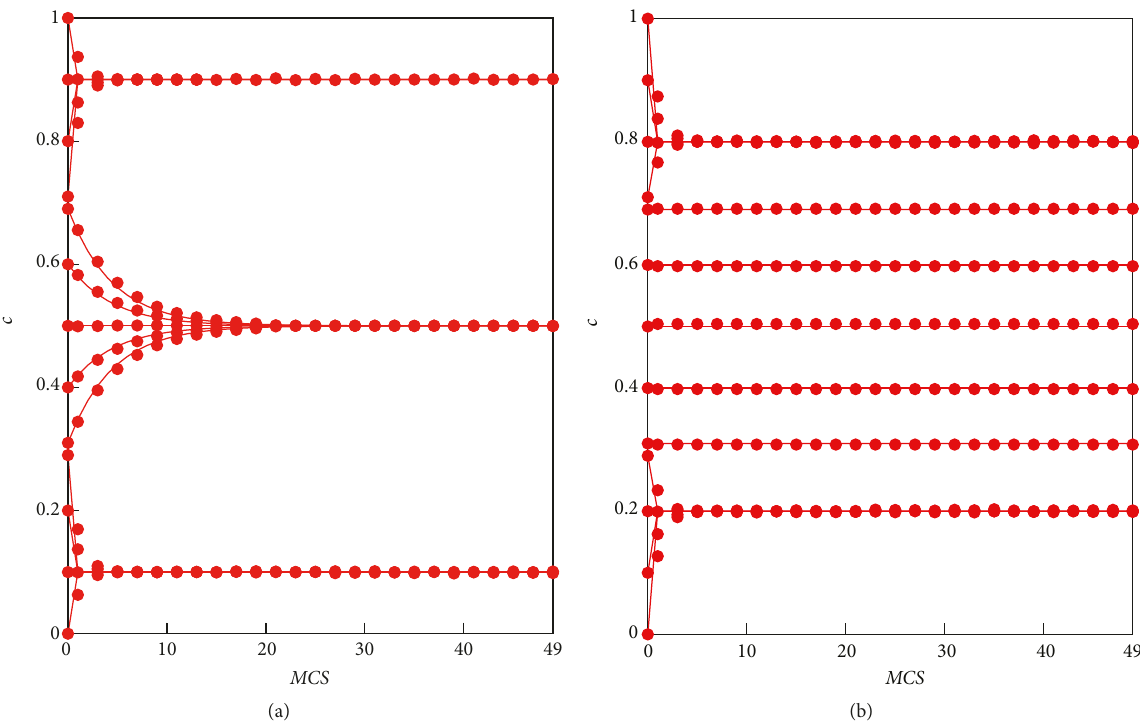
Figure 3: Average trajectories for the system of the size 𝑁 = 5 ⋅ 10 4 for the probability of nonconformity 𝑝 = 0.2 and models with (a) independence and (b) anticonformity both with 𝑟 = 0.7 Dots represent an outcome of the Monte Carlo simulations and solid lines refer to MFA results.